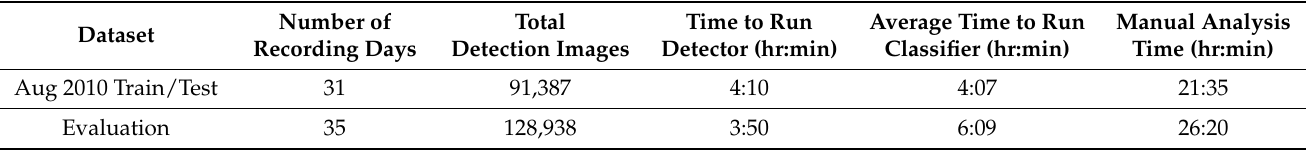
Table 5. Statistics on detector and classifier performance including the number of recording days, the number of detections selected by the energy detector, the amount of time (hr:min) it took the detector to run, the average amount of time it took the classifier to label the detection images from each dataset, and the amount of time it took the analyst to manually annotate each